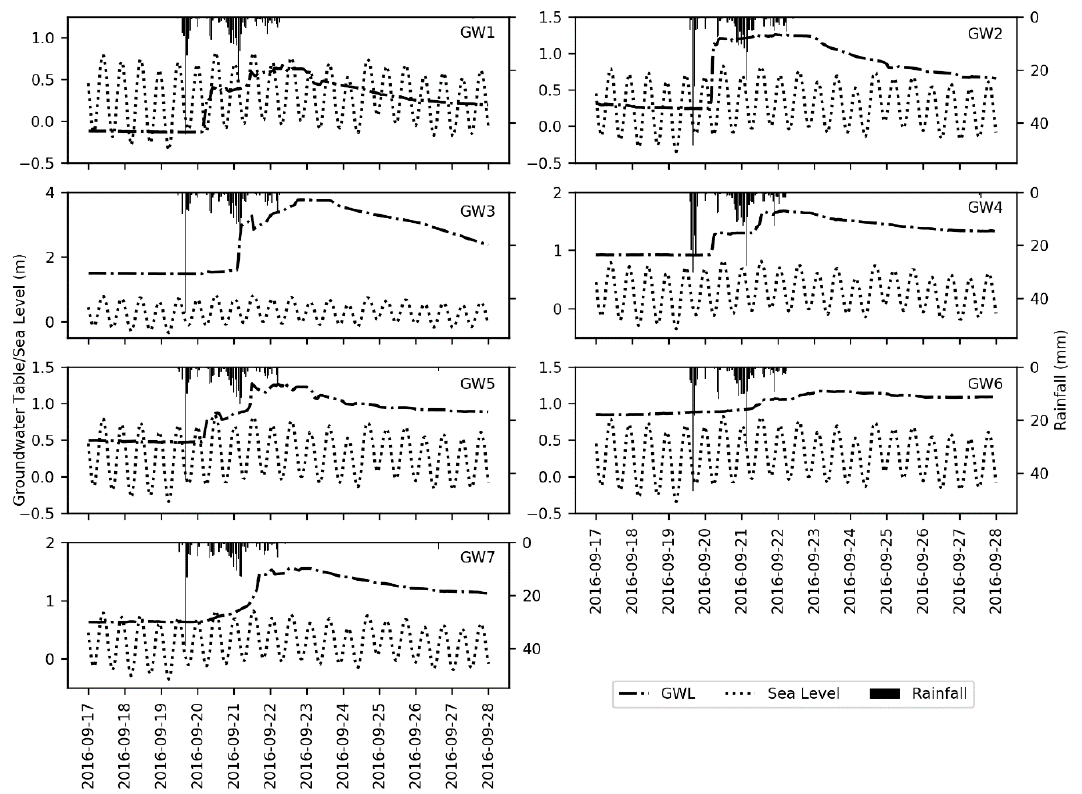
Figure 2. Hourly groundwater table level, sea level, and rainfall at individual wells for Tropical Storm Julia.